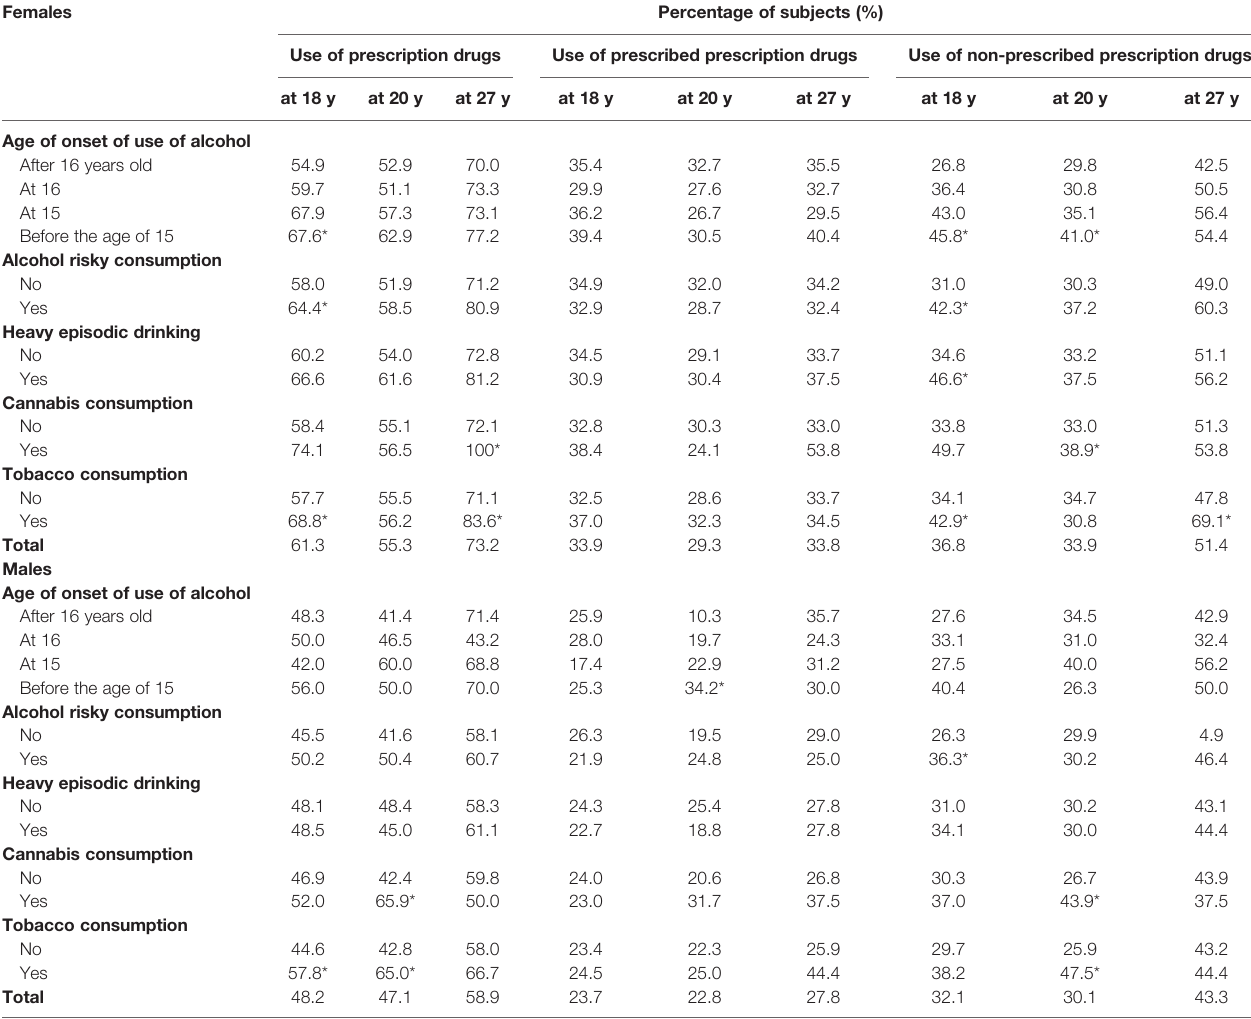
TABLE 3 | Use of prescription drugs at 18, 20, and 27 years old by pro fi les of substance use. Females Percentage of subjects (%) Use of prescription drugs Use of prescribed prescription drugs Use of non-prescribed prescription drugs at 18 y at 20 y at 27 y at 18 y at 20 y at 27 y at 18 y at 20 y at 27 y Age of onset of use of alcohol After 16 years old